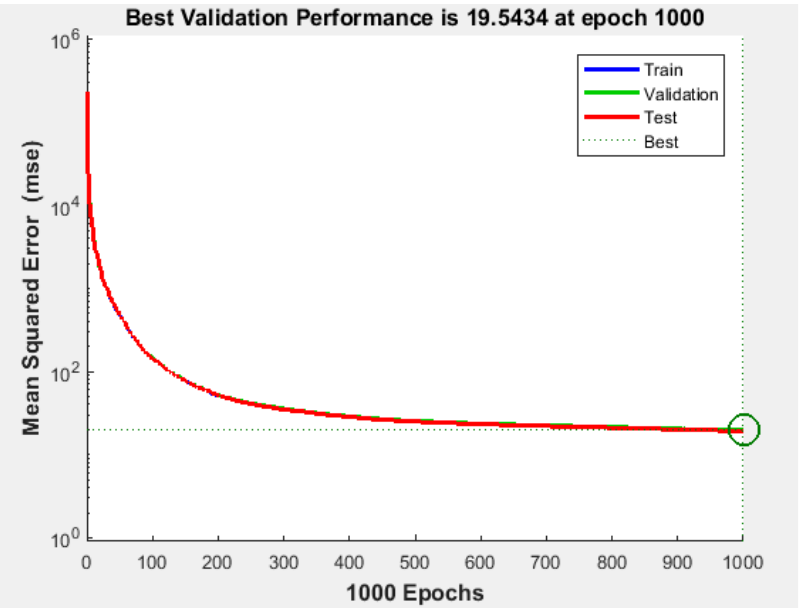
Figure 7. Performance of the training, validation, and testing data with the CGF learning algorithm at 400 neurons in the hidden layer.